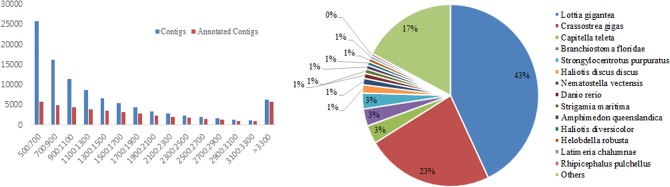
Assembly and annotation summary of H. discus hannai transcriptome.(A) Comparison of transcript length before and after annotation (B) Species distribution of transcript BLASTX results against the nr protein database. Different colors represent different species. Species with proportions of more than 1% are shown.